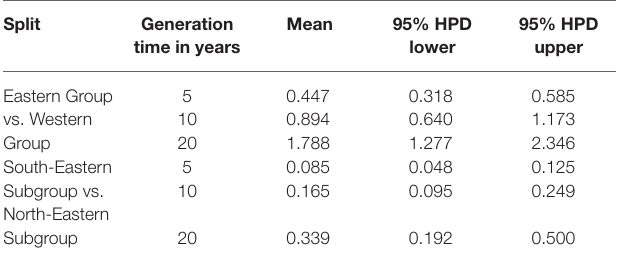
Divergence times estimates are based on a multispecies coalescent model using 500 randomly selected RADseq tags. Absolute times for each split were calculated for three different generation